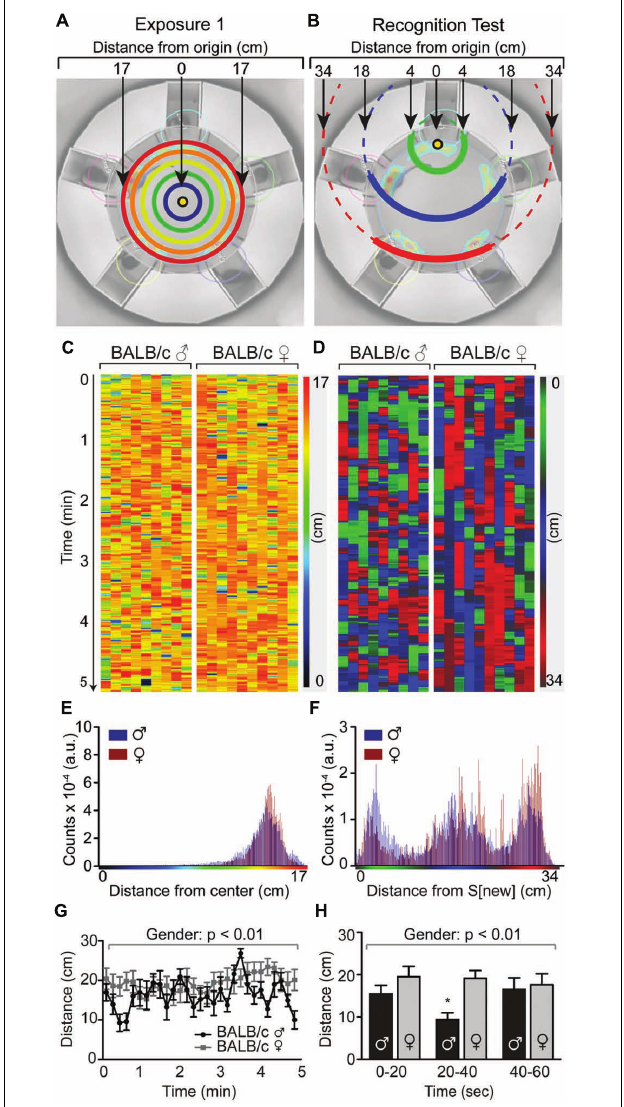
FIGURE 5 | Temporal distance heat maps identifies timing of social interaction in the SocioBox paradigm. Temporal heat map of the recognition test in male and female BALB/c mice, showing the distance of individual mice from the new stimulus mouse over time. (A,B) Schematic diagram showing the method used to calculate the distance of the experimental mouse from the point of origin, i.e., (A) the center of the arena during exposure 1 (or exposure 2, not shown); or (B) the new stimulus mouse during the recognition test. (C,D) Temporal distance heat maps showing the distance of individual BALB/c mice from the point of origin at each time point during (C) exposure 1 and (D) the recognition test. Each experimental mouse is represented in 1 column, with the vertical location corresponding to time, and color and intensity corresponding to the distance from the new stimulus mouse (as indicated in the calibration bar). (E,F) Frequency distributions of distances found in male (blue) and female (red) animals within the temporal distance heat map of (E) exposure 1 and (F) the recognition test. In the recognition test, 3 distance populations emerge, which correspond to the location of the new stimulus mouse S[new], the location of the constant stimulus mice immediately adjacent to the new stimulus mouse, i.e., S[ − 1] and S[ + 1], and the location of the constant stimulus mice opposite to the new